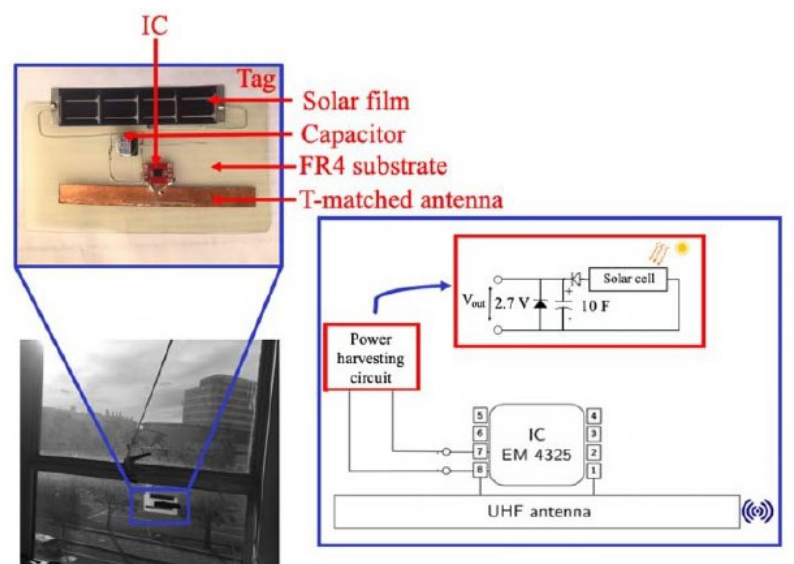
Figure 29. Implemented circuit of the temperature sensor [20].